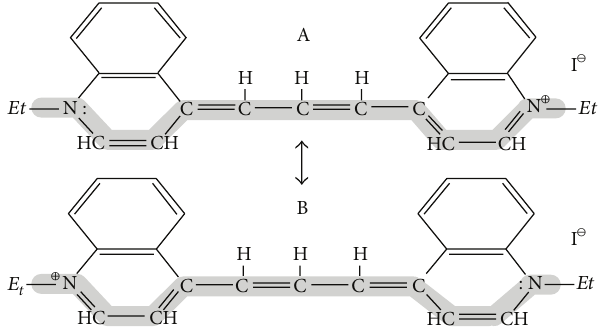
Figure 1: Two resonance structures of 1,1 󸀠 -diethyl-4,4 󸀠 -carbocya- nine iodide. The 𝜋 -electron system of interest is highlighted.